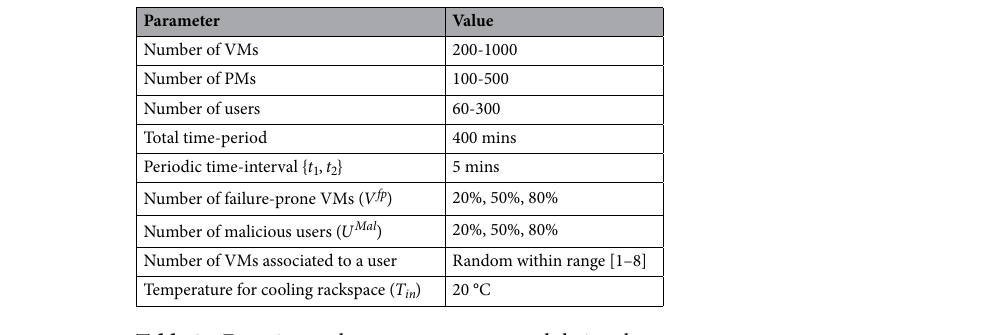
Table 3. Experimental set-up parameters and their values.